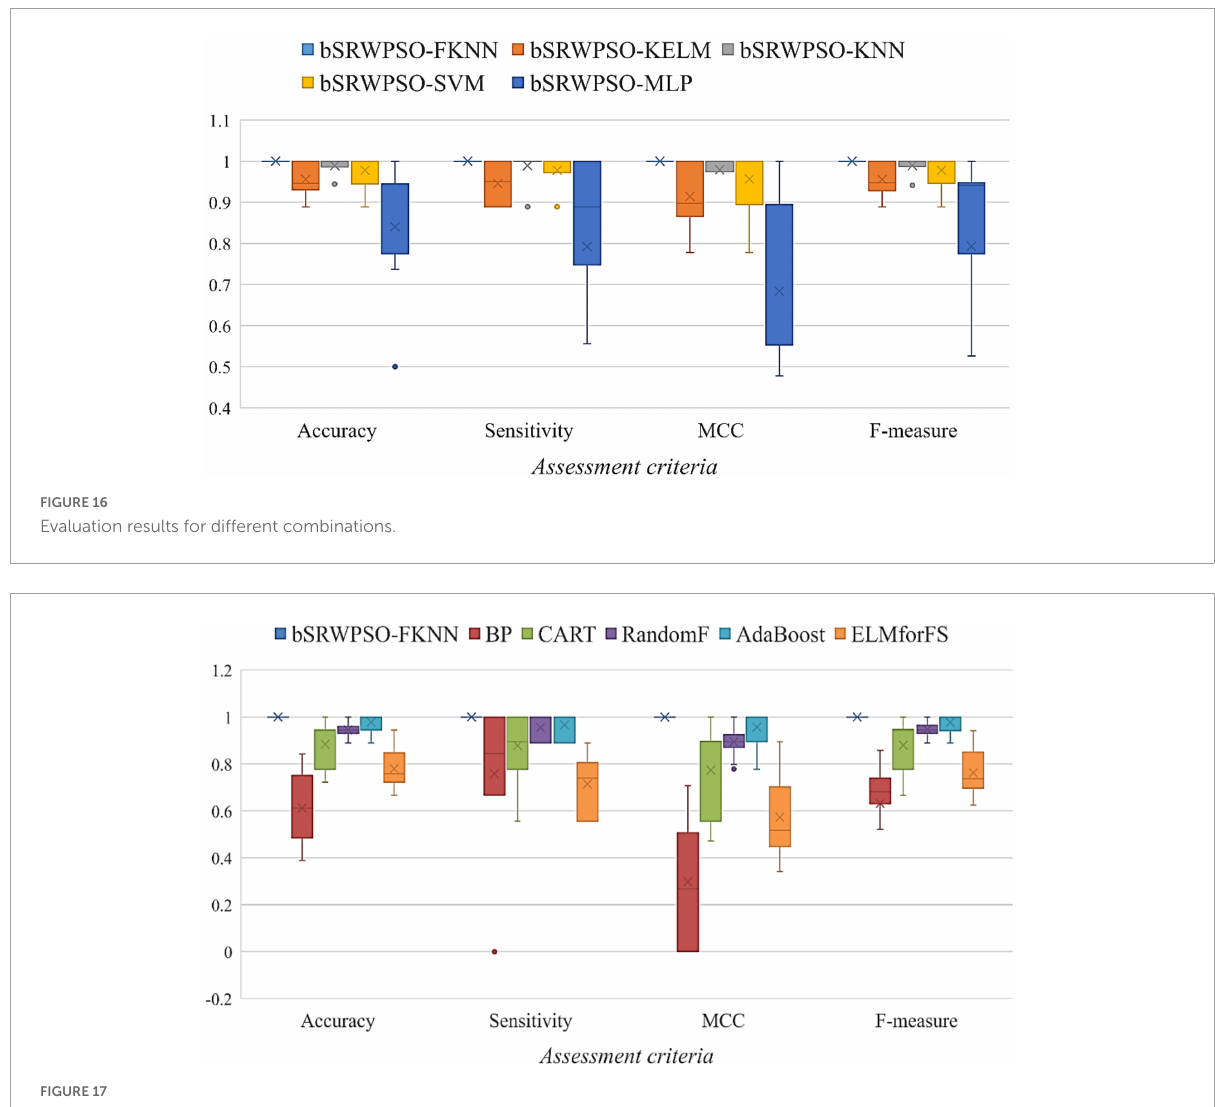
FIGURE17 The results of bSRWPSO with classical